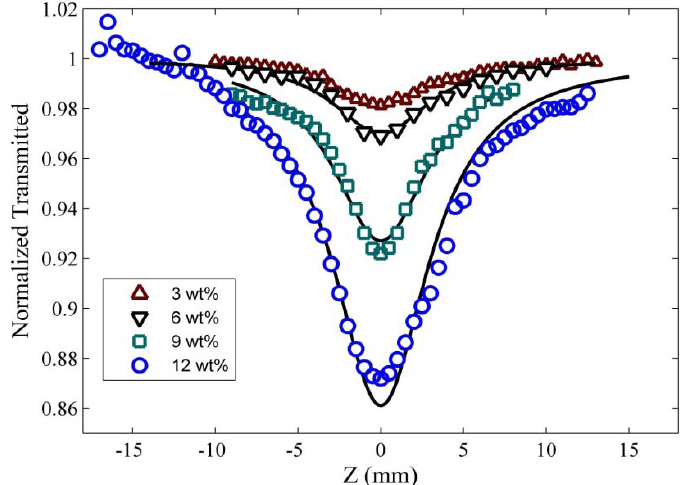
Figure 5. Normalized Z-scan transmittance curves of open-aperture for PPy/MWNT at different MWNT (wt %)